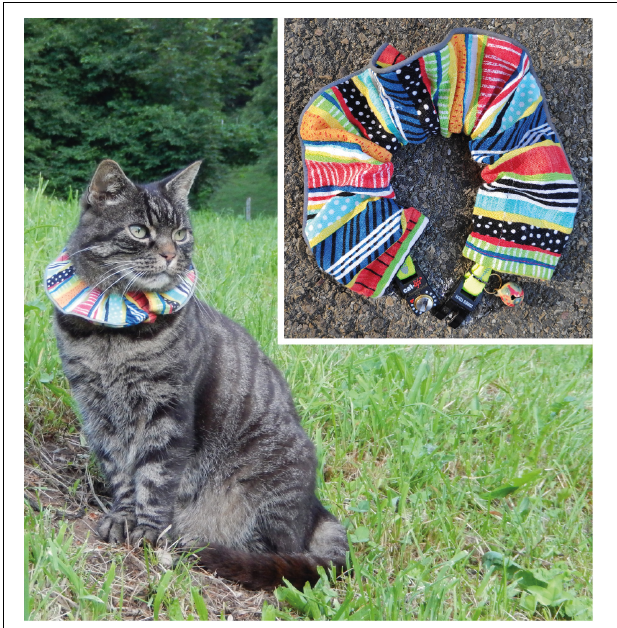
FIGURE 1 | One of the cats participating in our study, wearing a Birdsbesafe collar-cover. The inlet shows a close-up of the Birdsbesafe collar-cover, mounted on a quick-release collar (cat-life), which is also equipped with a bell. This type of collar-cover was used for all cats in the current study. Photograph courtesy by Kathi